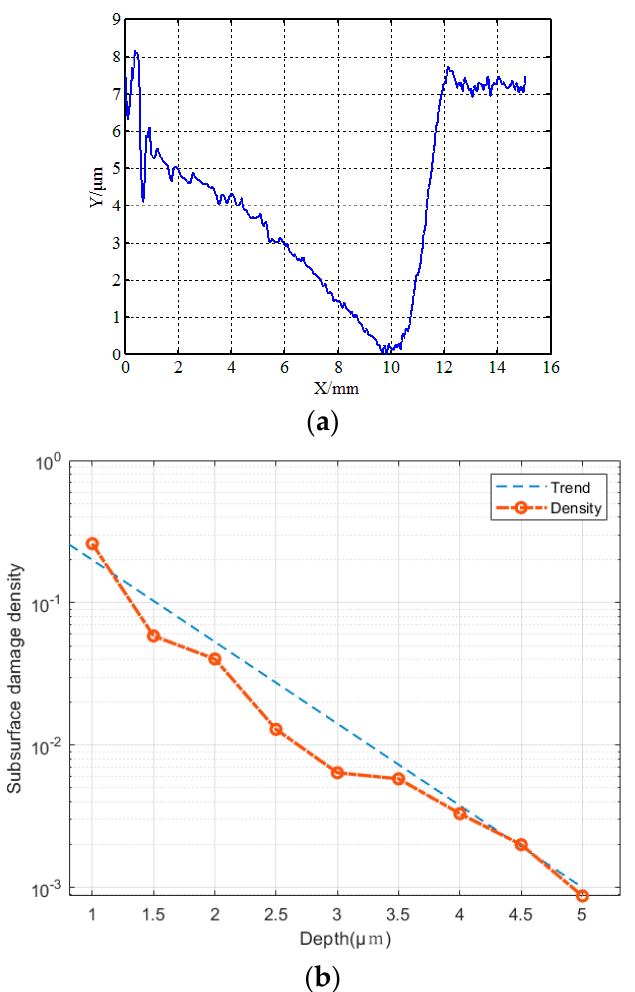
Figure 19. Magnetorheological spot profile and subsurface crack density. ( a ) Depth of profile. ( b ) Crack density distribution.